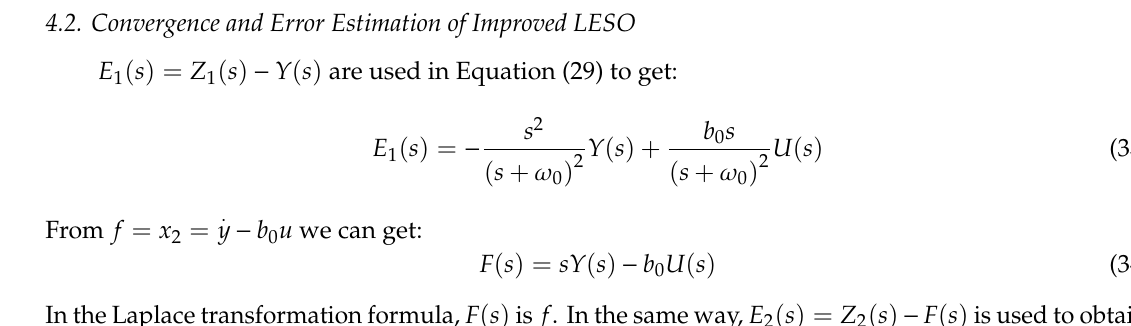
Figure 7. Frequency domain characteristic curve of input disturbance.